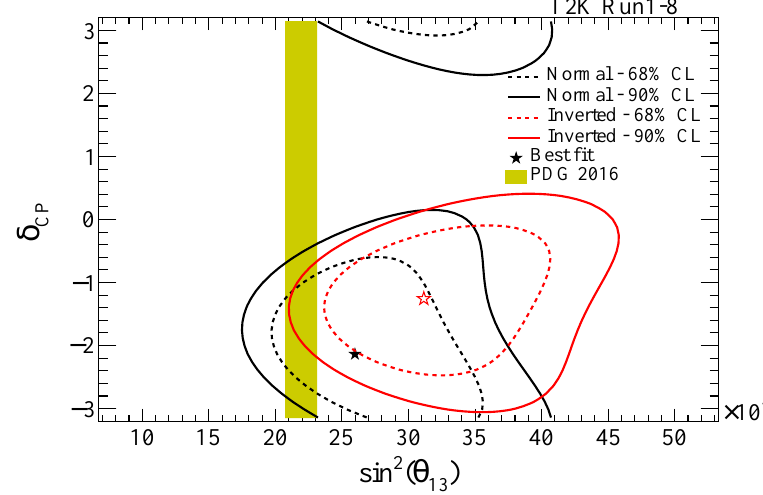
Figure 4. Confidence regions (68% and 90%) in the sin 2 θ 13 − δ CP plane as measured by T2K without any prior information on θ 13 compared with the 68% confidence regions from reactor experiments, shown by a yellow vertical